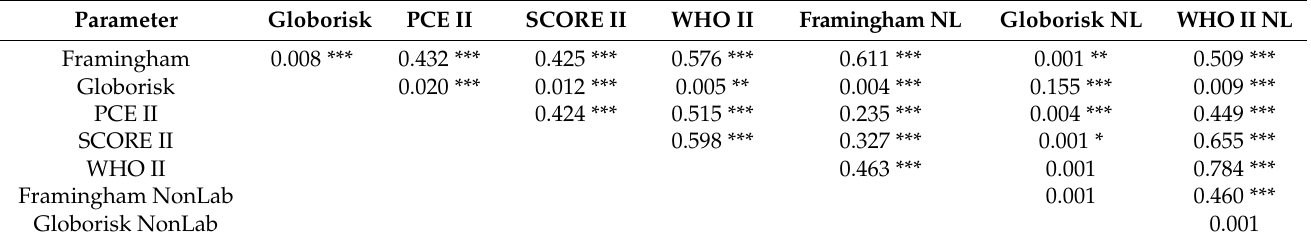
Table 6. Agreement in cardiovascular risk classification between risk scores among a multiethnic population living in the